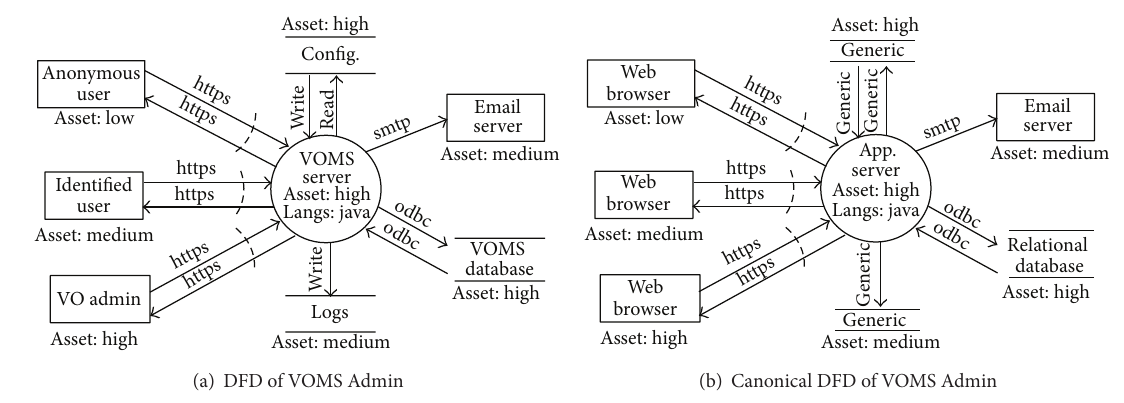
Figure 6: VOMS Admin